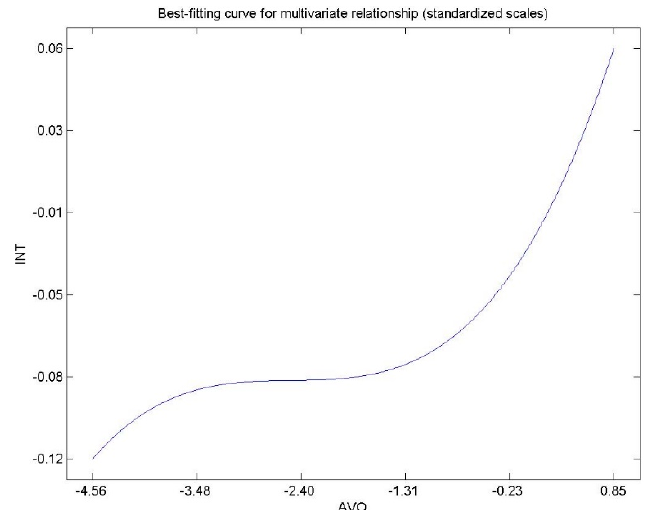
Figure 2. The non-linear relationship between altruistic values and the intention to adopt a minimalist lifestyle.